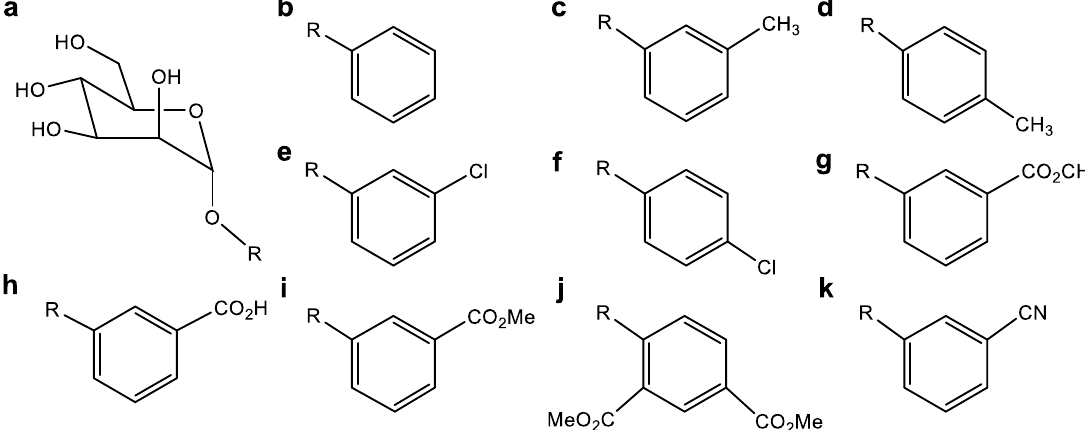
Figure 3. ( a ) Central nucleus of inhibitory molecules (mannose derivatives). ( b – k ) R substituents used as binders in the molecular coupling assays.